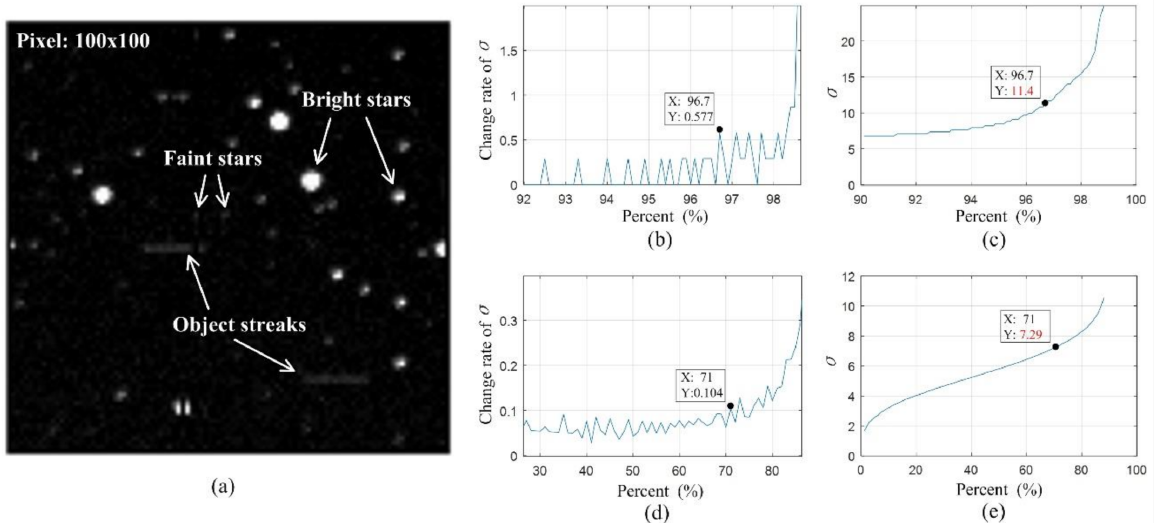
Figure 4. Standard deviation thresholdings with the GS method and SDS method. ( a ) A star image with bright stars, faint stars and object streaks. ( b ) σ change rate with GS method. ( c ) σ change with GS method.( d ) σ change rate with SDS method.( e ) σ change with SDS